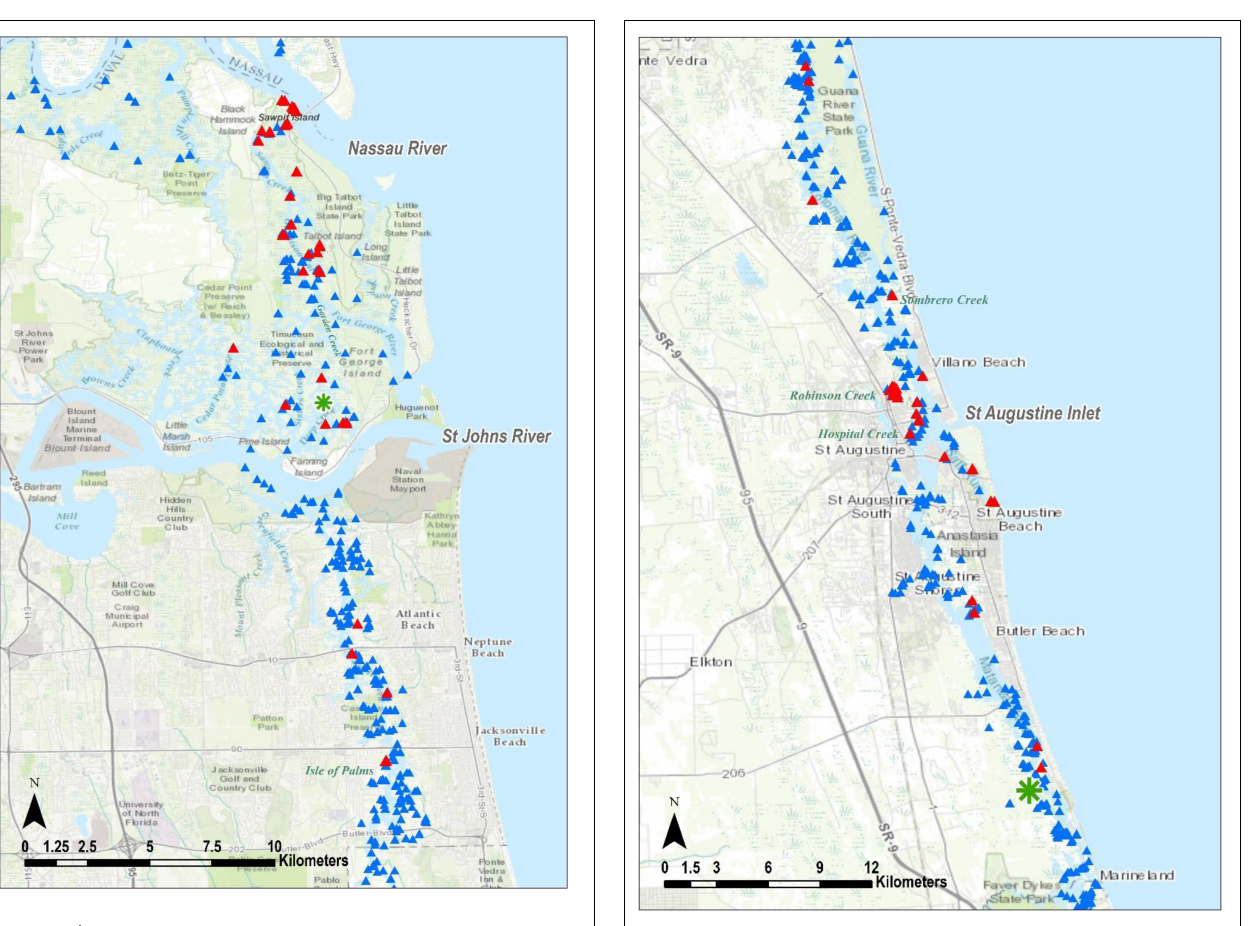
Figures 2 , 3 , respectively.